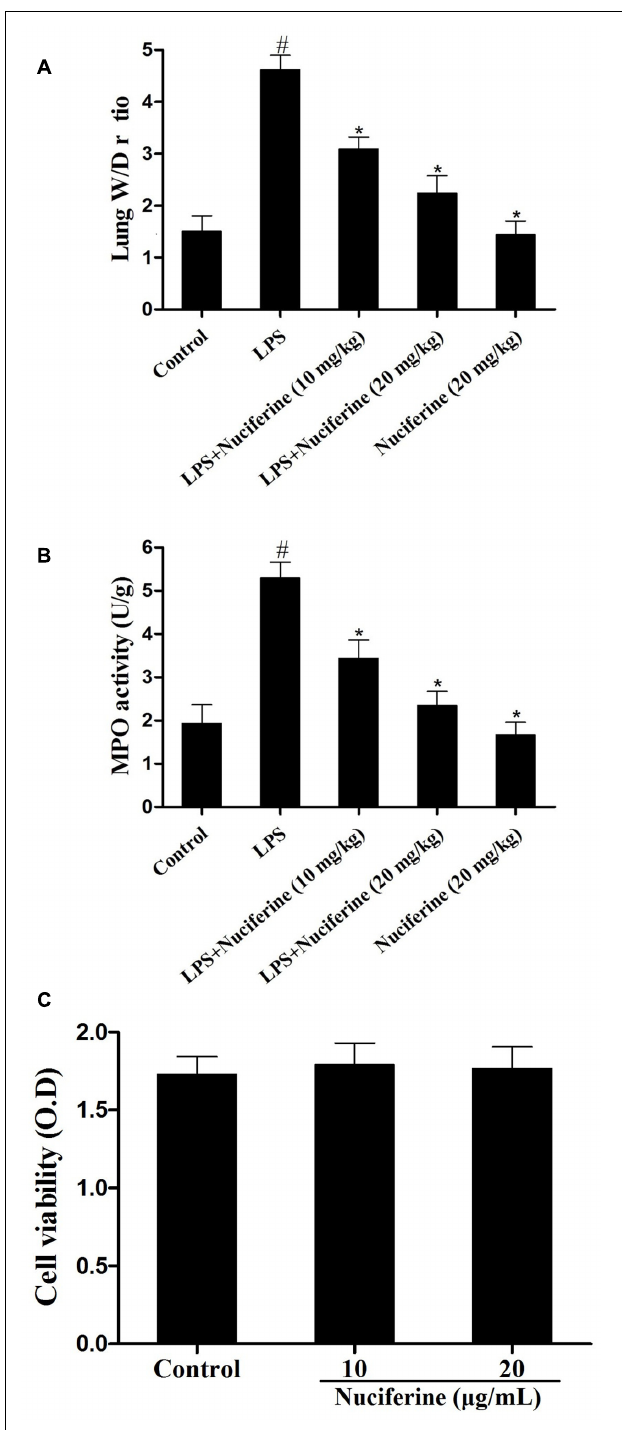
FIGURE 3 | Effects of nuciferine on the lung W/D ratio, MPO activity and cell viability. The lung W/D ratio and MPO activity were determined as described in section “Materials and Methods.” (A) Lung W/D ratio. (B) MPO activity. (C) RAW264.7 cells were cultured with various concentrations of nuciferine (0–20 µ g/mL) for 24 h. Cell viability was measured using an MTT assay. Data are represented as the mean ± SEM of three independent experiments. # p < 0.05 vs. Control group, ∗ p < 0.05 vs. LPS